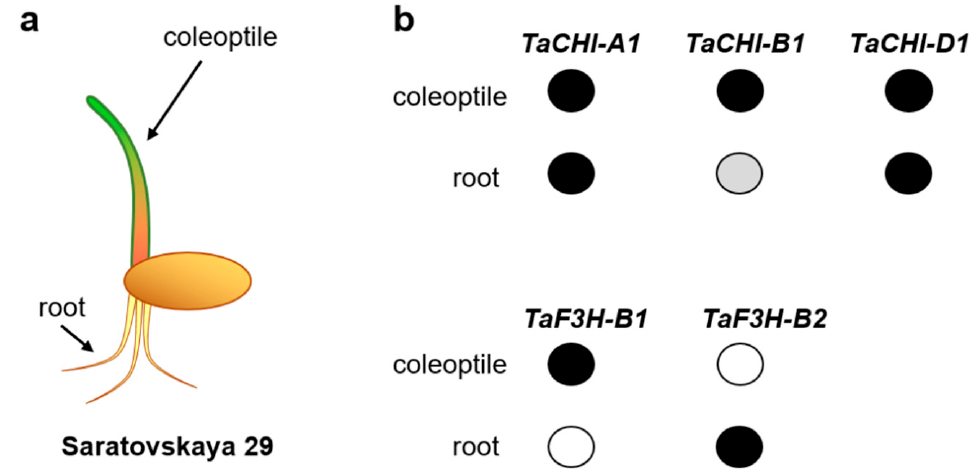
Figure 2. ( a ) A germinating grain of the wheat cultivar ‘Saratovskaya 29 (cid:48) . ( b ) Expression of the TaCHI-A1 , TaCHI-B1 and TaCHI-D1, plus TaF3H-B1 and TaF3H-B2 genes in ‘Saratovskaya 29 (cid:48) . The data concerning (1) TaCHIs expression were obtained using RT-PCR by [15], and (2) TaF3Hs expression were obtained using RT-PCR by [17]. The black circle means strong expression, the grey circle means weak expression, and the white circle means no